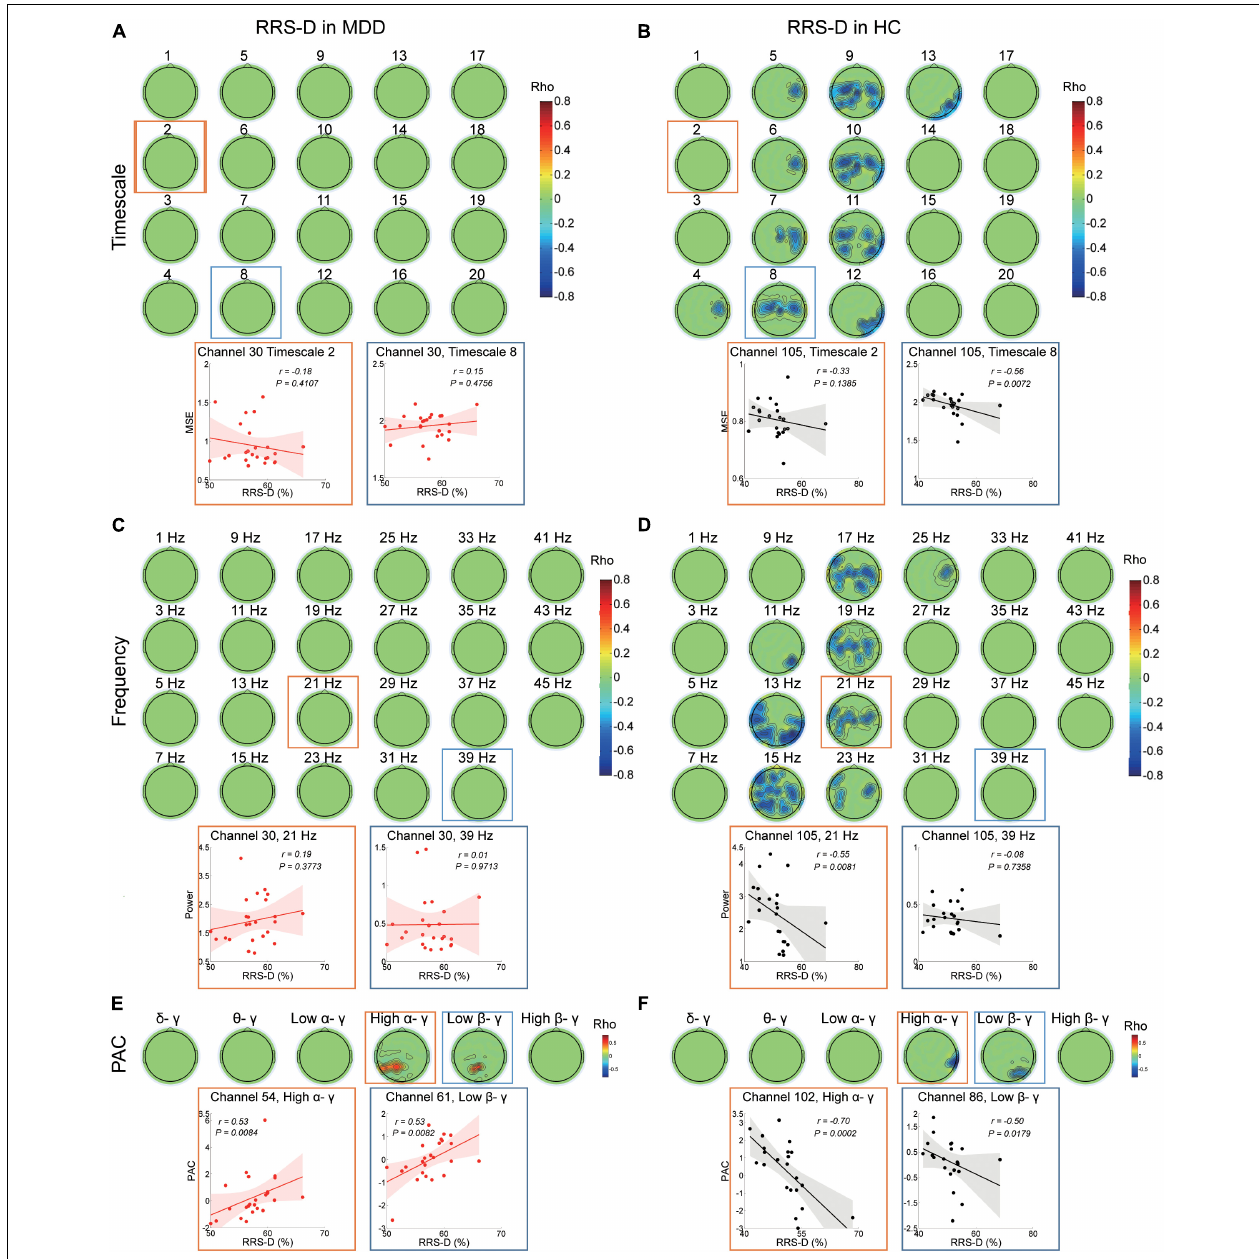
FIGURE 3 | Association between EEG dynamics and depressive rumination in both the MDD and HC groups. (A) Top: Topographies illustrate no significant (cluster P > 0.05) correlation between RRS-D scores and MSE in the MDD group. Bottom: Scatter plots show examples in the central region at the fine (channel 30, timescale 2, r = –0.18, P = 0.411) and coarser timescales (channel 30, timescale 8, r = 0.15, P = 0.476). (B) Top: Topographies illustrate the significant correlation between the RRS-D scores and MSE in the HC group (positive cluster P = 0.041). Bottom: Scatter plots show examples in the central region at the fine (channel 105, Timescale 2, r = –0.33, P = 0.139) and coarser timescales (channel 105, timescale 8, r = –0.56, P = 0.007). (C) Top: Topographies illustrate no significant (clusters P > 0.05) correlation between RRS-D scores and power (presented with a step of 2 Hz) in the MDD group. Bottom: Scatter plots show examples in the central region in the beta (channel 30, 21 Hz, r = 0.19, P = 0.377) and gamma bands (channel 30, 39 Hz, r = 0.01, P = 0.971). (D) Top: Topographies illustrate the significant correlation (negative cluster P = 0.037) between the RRS-D scores and power (presented with a step of 2 Hz) in the HC group. Bottom: Scatter plots show examples in the central region in the beta (channel 105, 21 Hz, r = –0.55, P = 0.008) and gamma bands (channel 105, 39 Hz, r = –0.08, P = 0.736). (E) Top: Topographies illustrate the significant correlation between the RRS-D scores and PAC in the MDD group (positive cluster P high α / γ = 0.007 and P low β / γ = 0.022). Bottom: Scatter plots show examples of high alpha/gamma in the parietal region (channel 54, r = 0.53, P = 0.008) and low beta/gamma PAC in the parietal region (channel 61, r = 0.53, P = 0.008). (F) Top: Topographies illustrate the significant correlation between RRS-D scores and PAC in the HC group (negative cluster P high α / γ = 0.042 and P low β / γ = 0.028). Bottom: Scatter plots show examples of high alpha/gamma in the parietal region (channel 102, r = –0.70, P < 0.001) and low beta/gamma in the parietal region (channel 86, r = –0.50, P = 0.018)